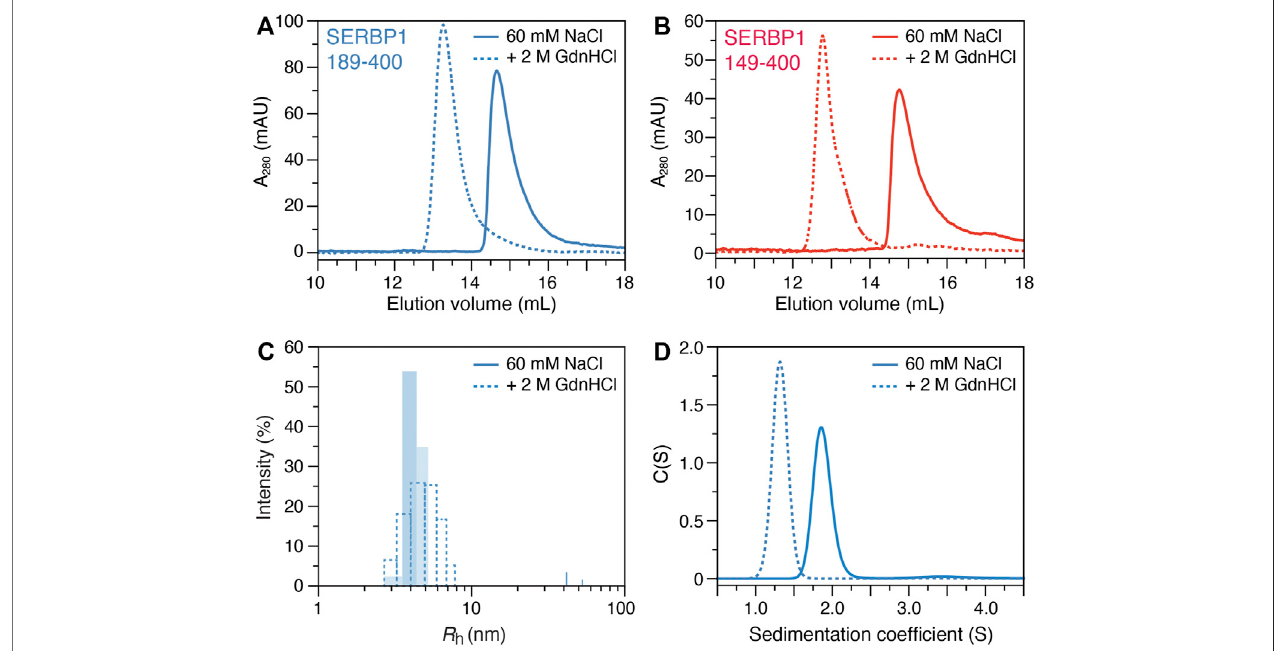
FIGURE 4 | Biophysical characterization of SERBP1 oligomer state in solution. Size exclusion chromatography pro fi les of (A) SERBP1 189 – 400 and (B) SERBP1 149 – 400, respectively, in the absence (solid) and presence (red) of 2 M GdnHCl recorded at A 280 . (C) Size distribution histograms of the apparent hydrodynamic radius ( R h ) derived from dynamic light scattering experiments of SERBP1 189 – 400 in the absence (solid) and presence (dashed) of 2 M GdnHCl. (D) Analytical ultracentrifugation sedimentation velocity coef fi cient pro fi les of SERBP1 189 – 400 in the absence (solid) and presence (dashed) of 2 M GdnHCl.